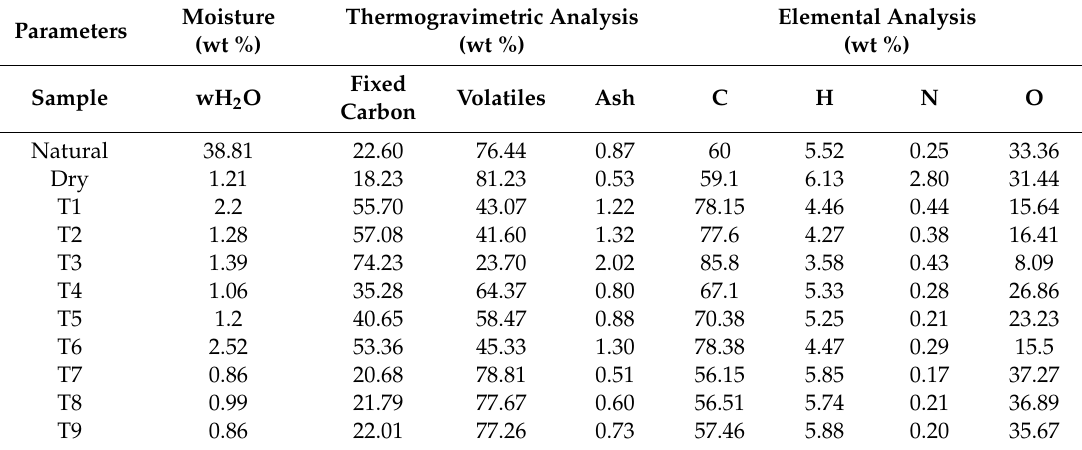
Table 3. Results obtained from moisture content determination, thermogravimetric and elemental analysis, for the analyzed samples: green, dried, and torrefied